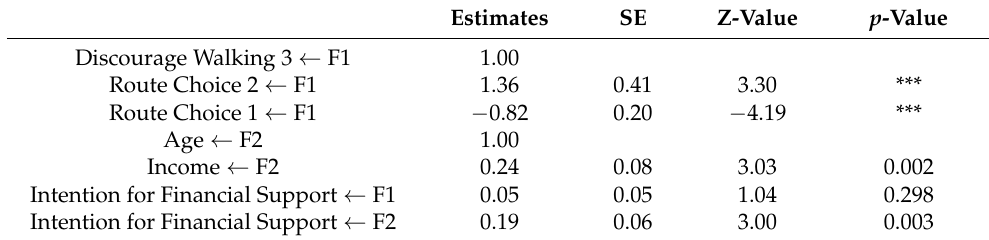
Table 4. Regression Weights ←